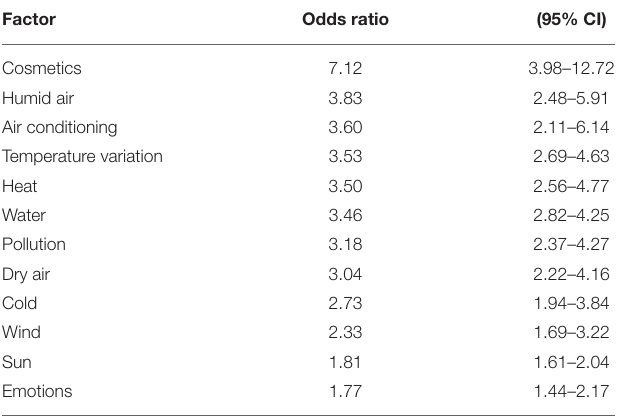
TABLE 2 | Triggering factors of sensitive skin suggested by interviewees in